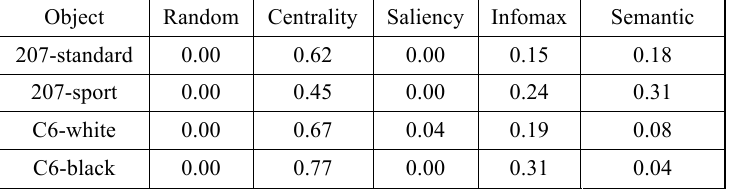
Table 3: Contribution of each factor for each experimental condition (free viewing task). First of all, the “Random” factor does not contribute to the model: the fixations are not randomly distributed and they can be explained by the other factors. Secondly,